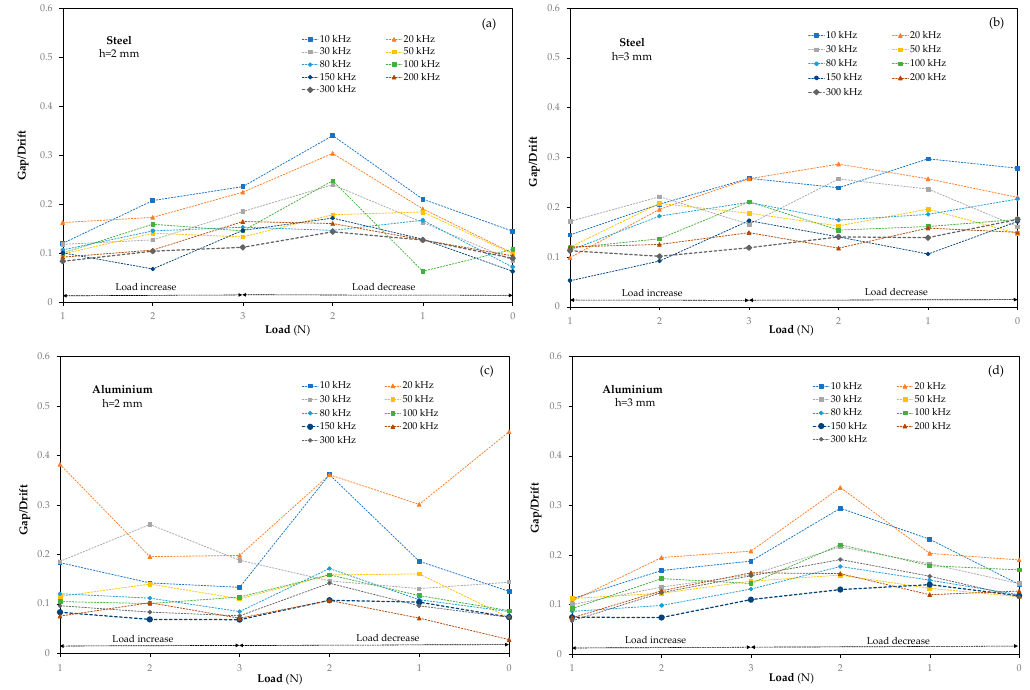
Figure 7. Gap/ drift ratio behaviour during load and unload test for ( a ) steel 2 mm thick, ( b ) steel 3, ( c ) aluminium 2 and ( d ) aluminium 3 mm thick.